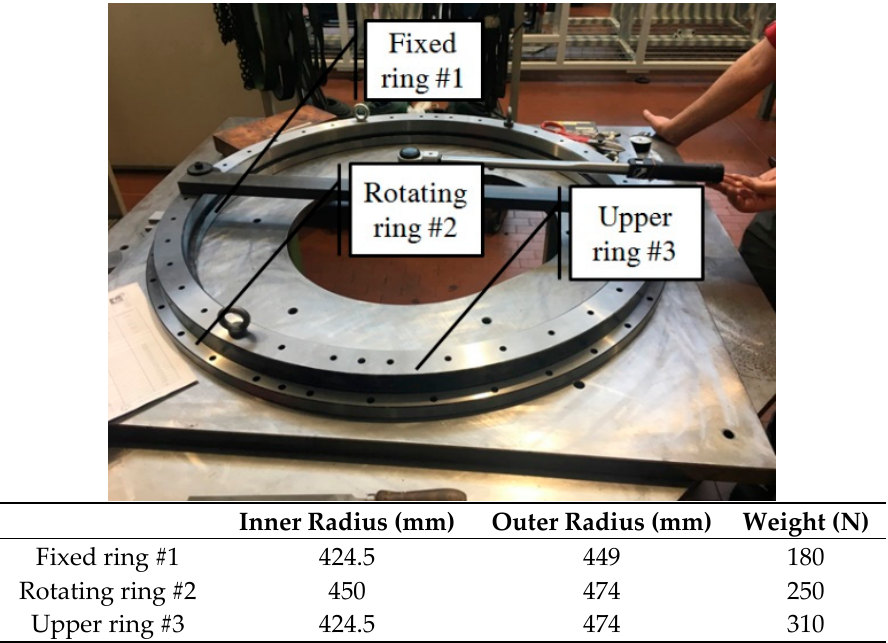
Figure 10. Hirth ring connection with a mean diameter of 900 mm and z = 360.